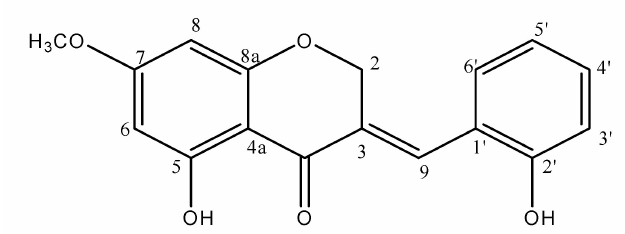
Figure 1. HM-chromanone of chemical